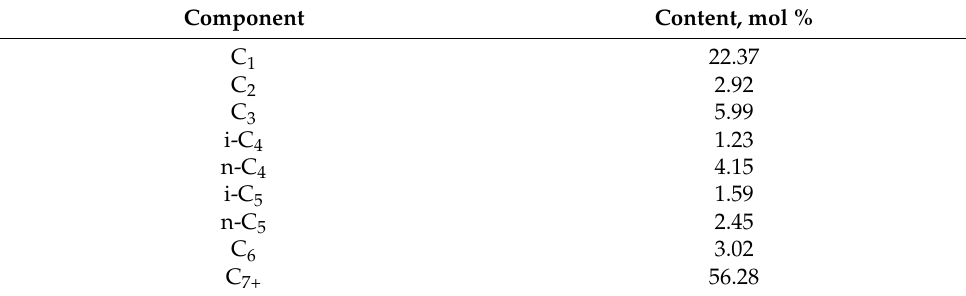
Table 2. Composition of recombined